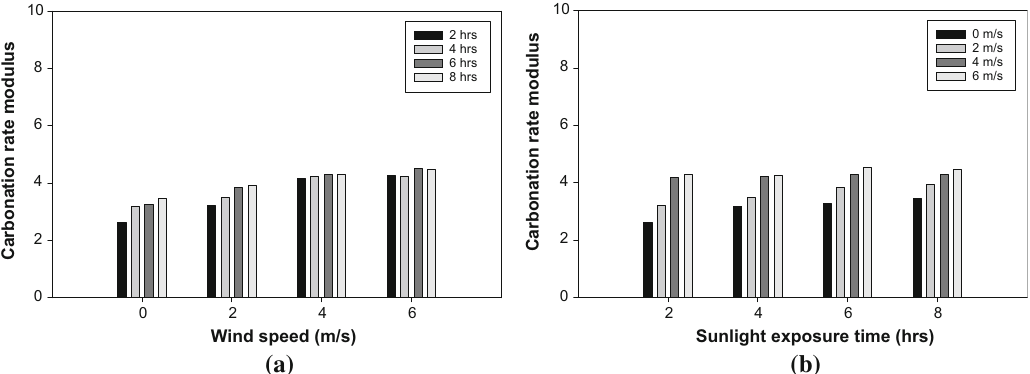
Fig. 3 Carbonation rate modulus versus wind speed and sunlight exposure time. a Wind speed with 0, 2, 4, 6 m/s. b Sunlight exposure time with 2, 4, 6, 8